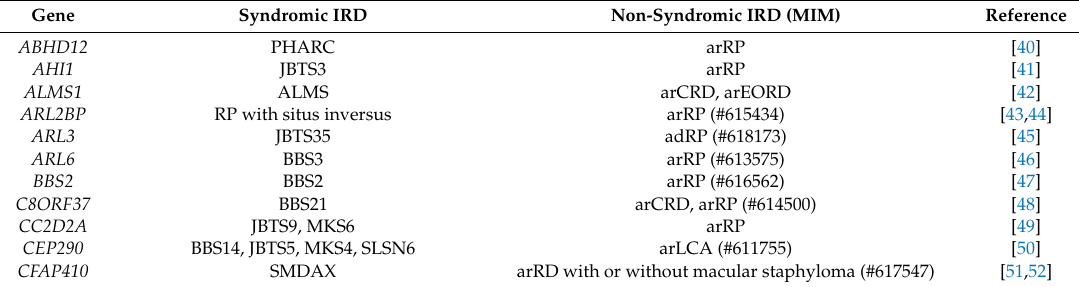
Table 2. Genes underlying both syndromic and non-syndromic IRDs.